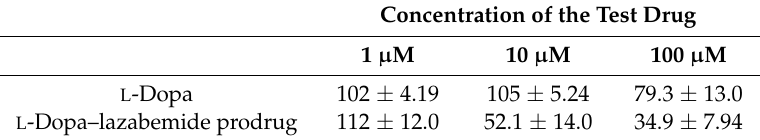
Table 3. The percentage of viable cells remaining after treatment with the L -dopa–lazabemide prodrug and L